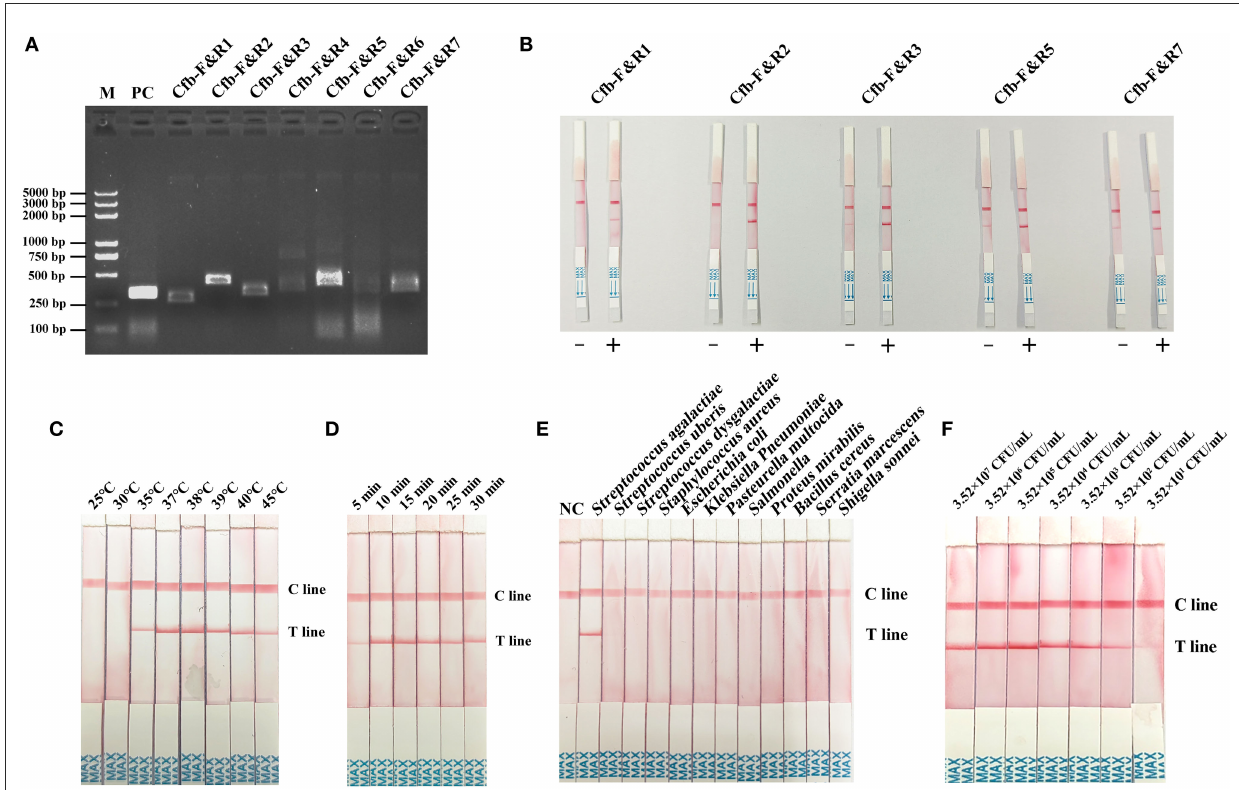
FIGURE3 (A) Primer primary screening by the MIRA reaction. M = Marker, PC = positive control, Cfb-F&R1, Cfb-F&R2, Cfb-F&R3, Cfb-F&R4, Cfb-F&R5, Cfb-F&R6, and Cfb-F&R7 = primer pairs. (B) Primer rescreening by MIRA–LFD reaction. “–” = a negative reaction which utilized pure water as a template. “ + ” = a positive reaction followed by the normal MIRA–LFD reaction. Cfb-F&R1, Cfb-F&R2, Cfb-F&R3, Cfb-F&R5, and Cfb-F&R7 = primer pairs. (C) Reaction temperature screening for MIRA–LFD. C line = the control line, T line = the test line. (D) Reaction time shifting for MIRA–LFD. C line = the control line, T line = the test line. (E) Specificity of the complete method (DED–MIRA–LFD). NC = negative control. C line = the control line, T line = the test line. (F) Sensitivity of the complete method (DED–MIRA–LFD).